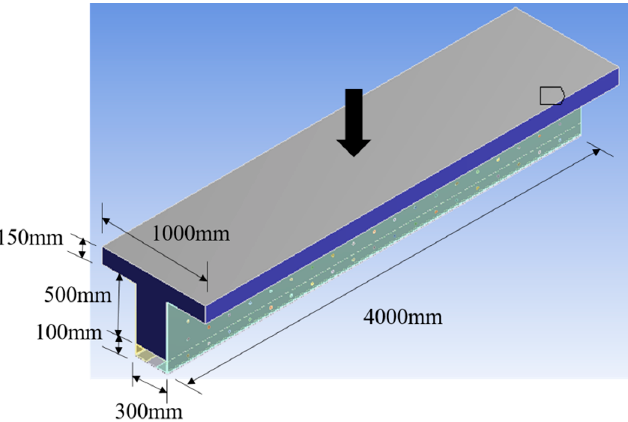
Figure 3. Finite element model.